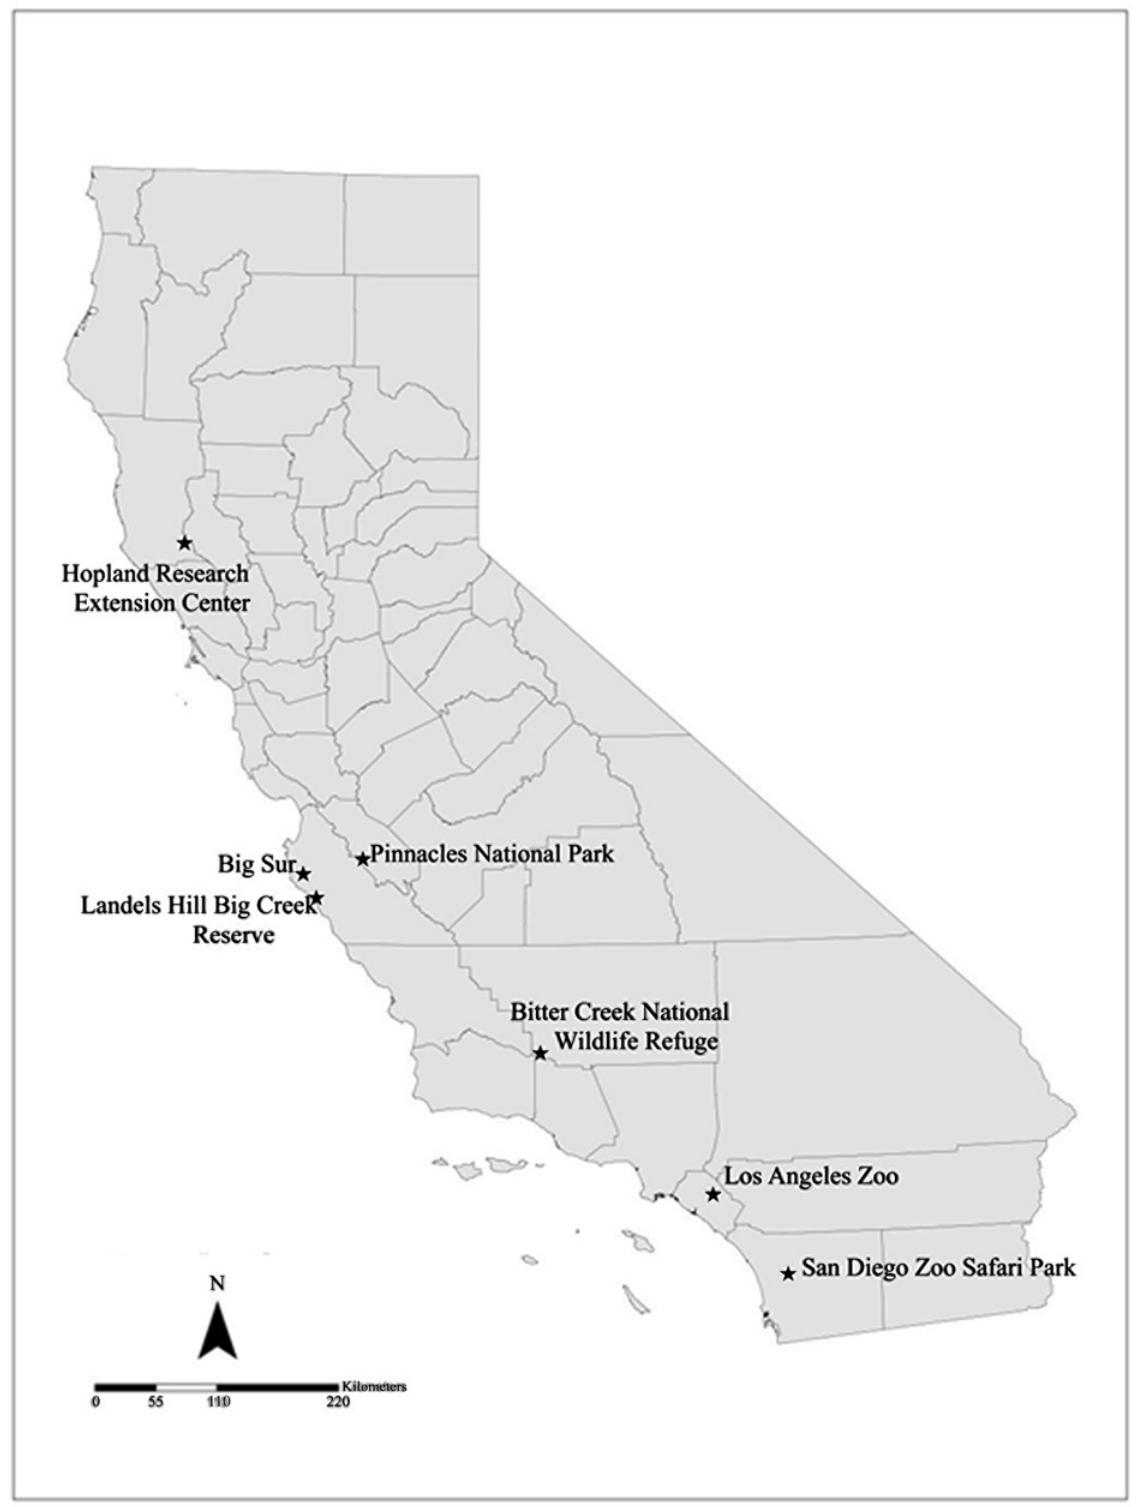
Fig 1. Sampling sites of California condors, golden eagles and turkey vultures in California. Sampling sites designated by black stars.